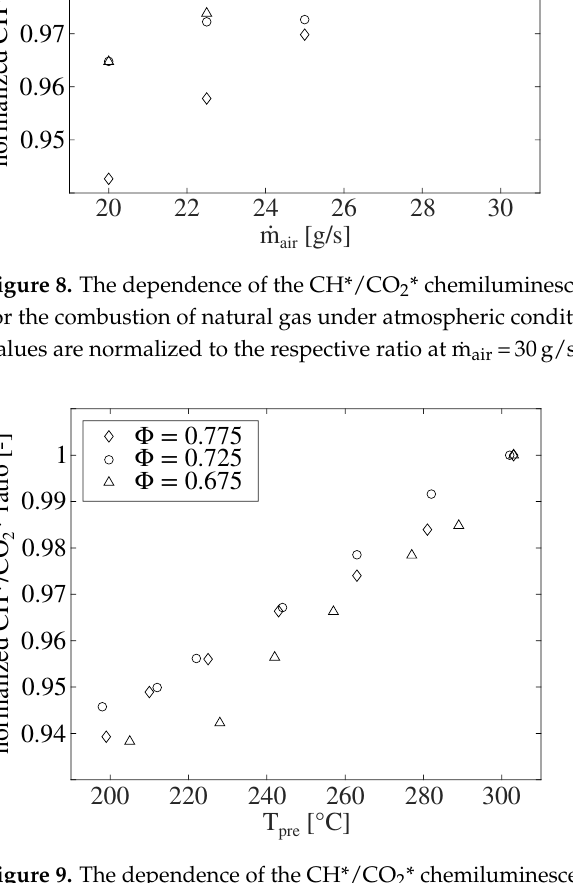
Figure 9. The dependence of the CH*/CO 2 * chemiluminescence ratio on the preheating temperature T pre for the combustion of natural gas under atmospheric conditions for different equivalence ratios. All values are normalized to the respective ratio at T pre =300 ◦